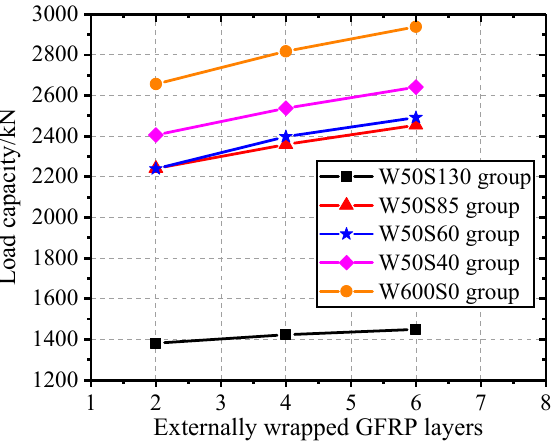
Figure 11. Impact of the GFRP fiber layers on the load capacity.